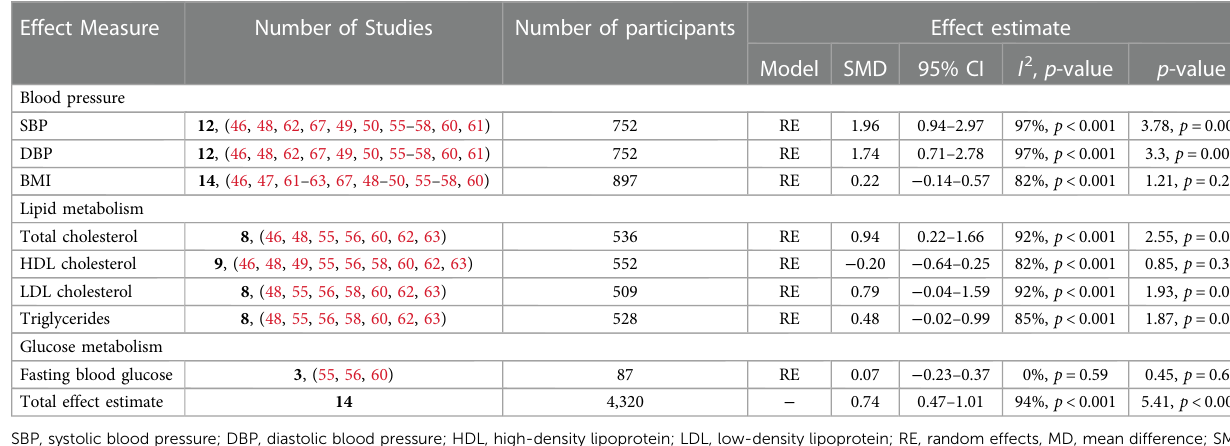
TABLE 2 Traditional cardiovascular-risk variables of included participants.